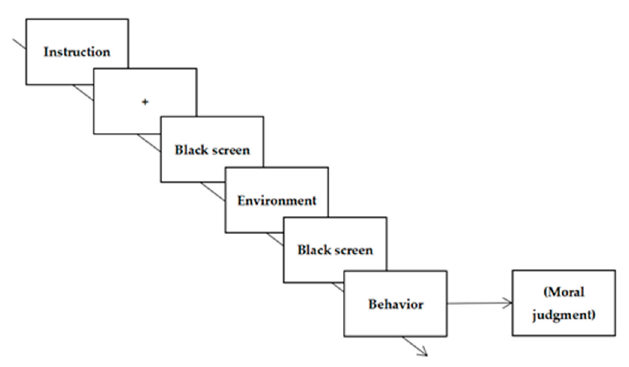
Figure 6. Example of event sequences on the moral judgment task in Experiment 2b.